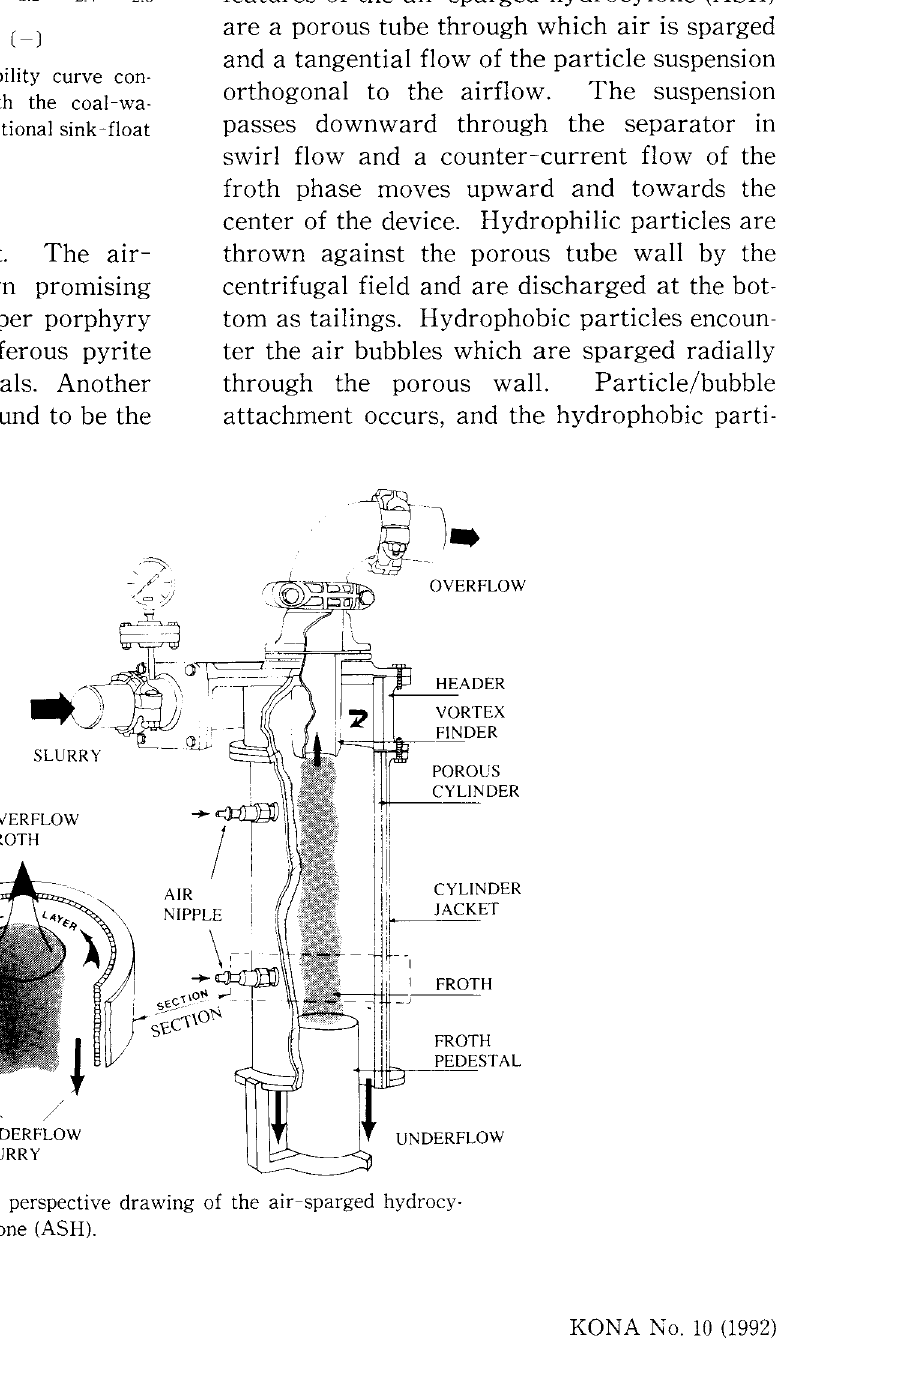
Fig. 11 A perspective drawing of the air-sparged hydrocy clone